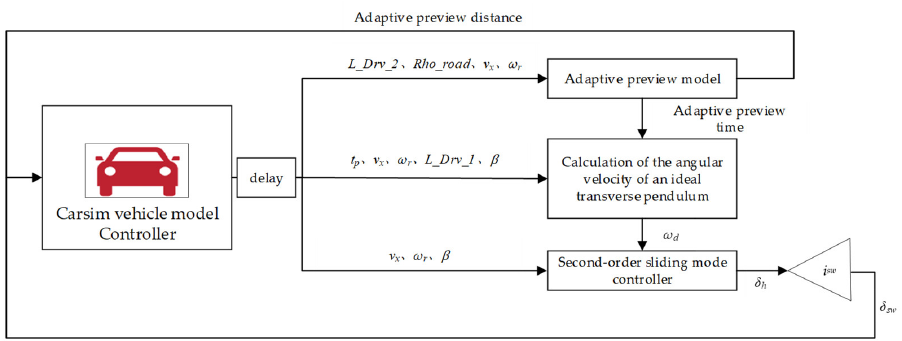
13 of 21 Table 2. Parameters of MPC algorithm. Parameters